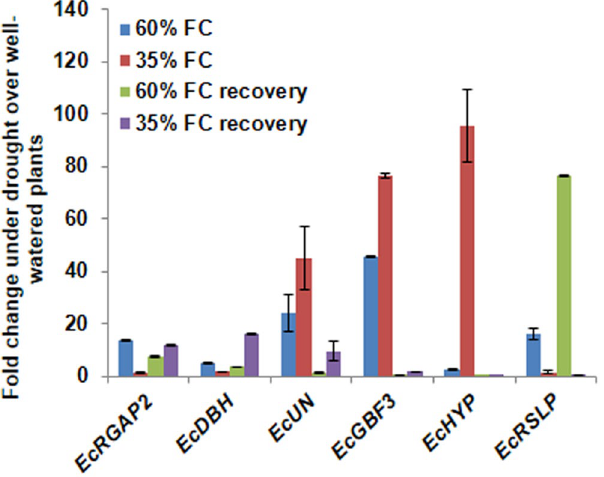
Figure 1. Expression of finger millet genes under drought stress and recovery. Total RNA from leaf samples subjected to different drought stress levels and recovery were used for RT-qPCR analysis. The data was normalized to EcActin expression levels and the relative change over control plants was calculated using 2 −ΔΔ Ct method. The values are mean ± SE of two biological replicates performed in two different